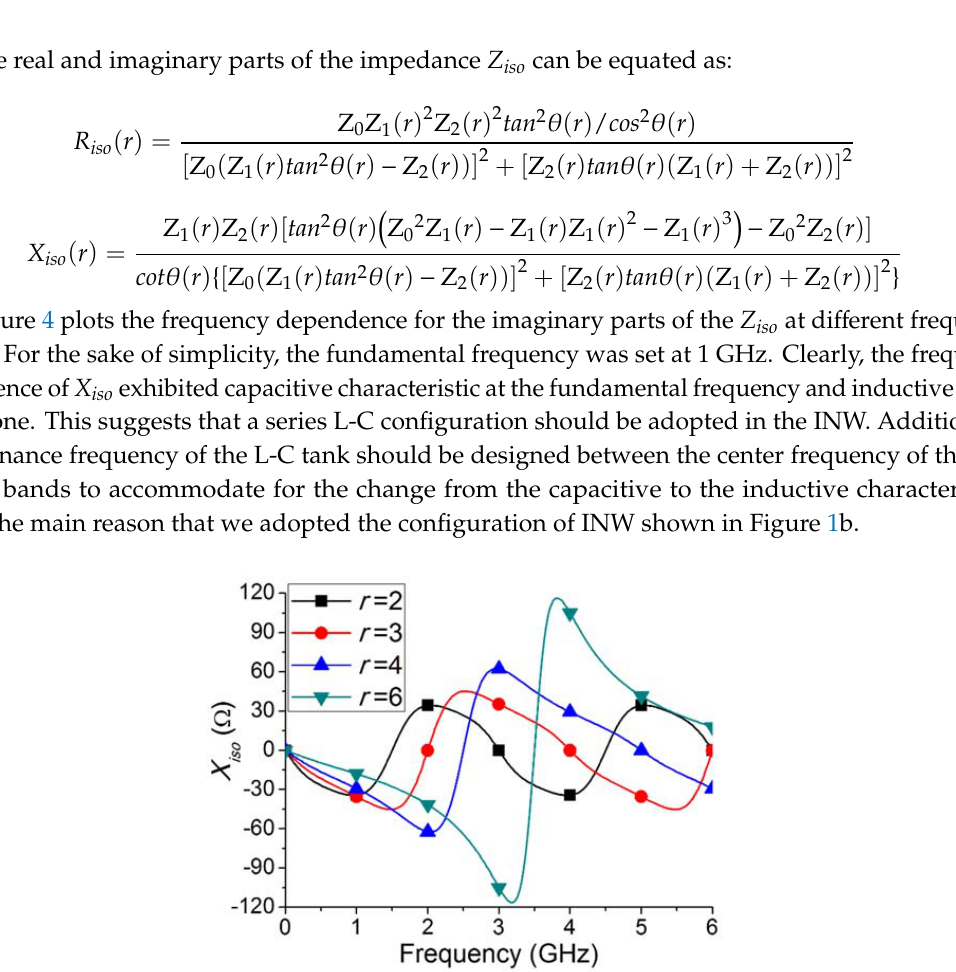
Figure 4. Frequency dependence of X iso under various frequency ratios r with the fundamental frequency set at 1 GHz.